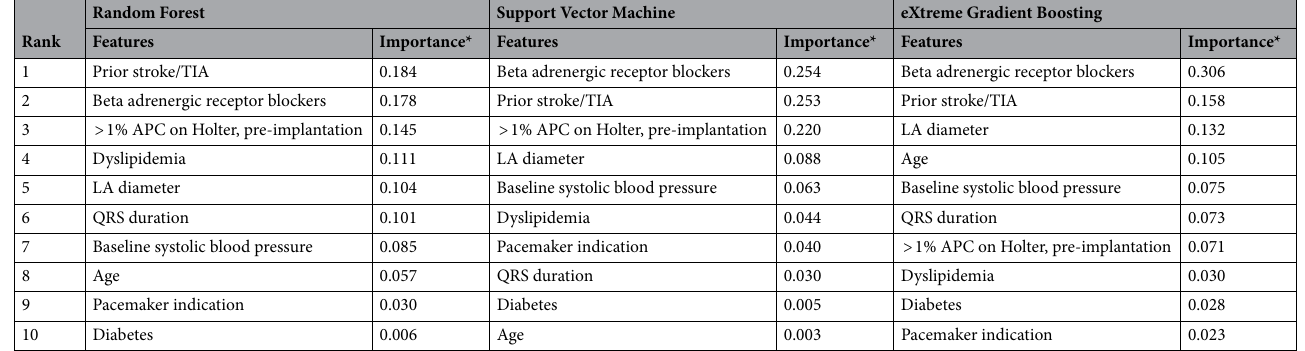
Table 3. Feature importance in the three machine learning-based models. AAD average absolute deviation, APC atrial premature contraction, CI confidence interval, TIA transient ischemic attack, LA left atrium. * Feature importance was measured from sensitivity analysis.